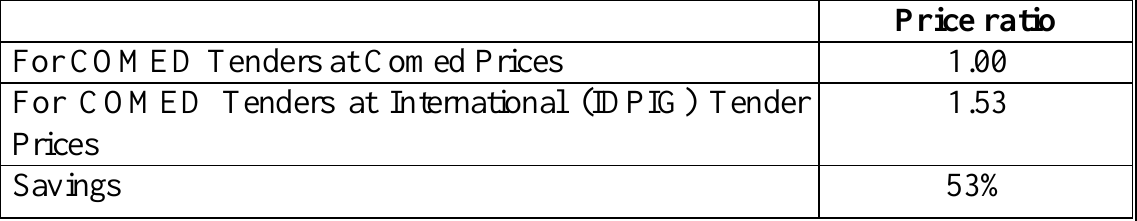
Table 6 Comed-IDPIG comparison for 71 common products,